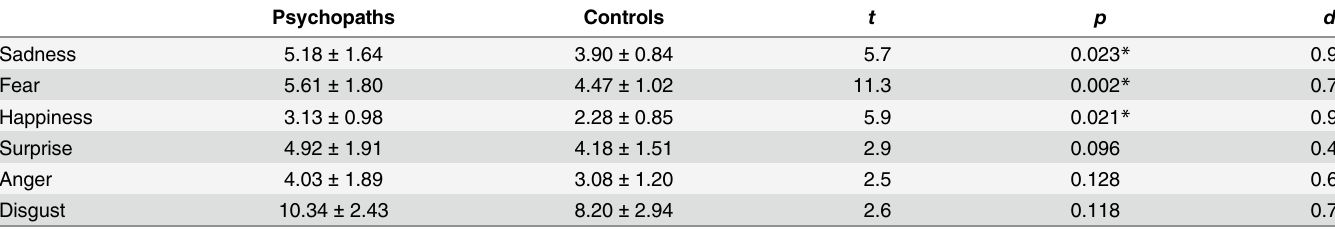
Table 2. Emotional face task performance. Mean number of steps needed to recognize each particular emotion ±